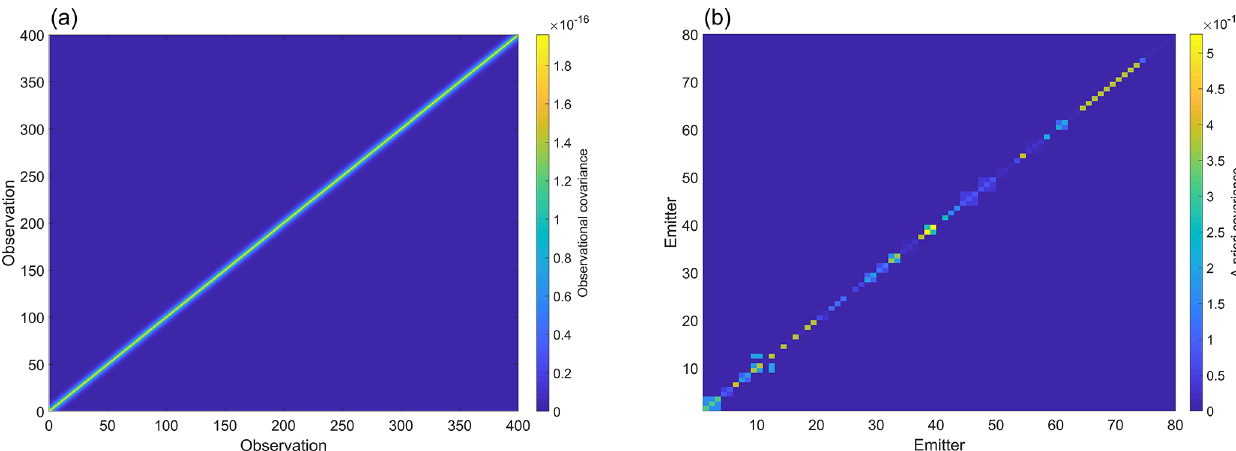
Figure 7. (a) Observational covariance augmented with a first-order autoregressive model AR(1) structure with ϕ = 0 . 7. (b) A priori covari- ance matrix highlighting correlated clusters from individual ventilation shafts. The scaling factor results from the scaling of the FLEXPART- WRF plume to the designated flux unit ktyr − 1 .